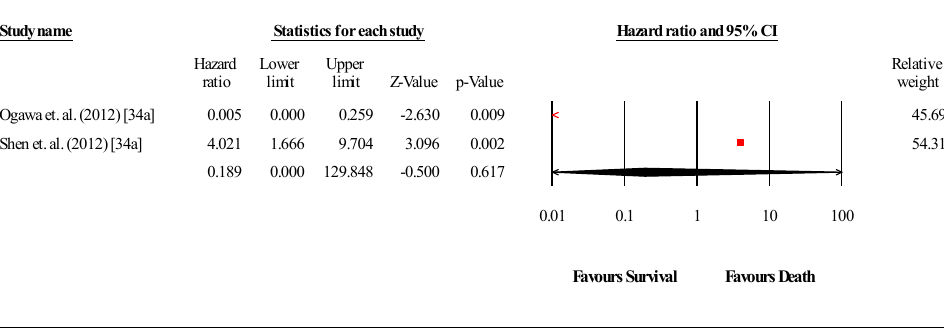
Figure 13. Forest plot for miR-34a association with DFS.